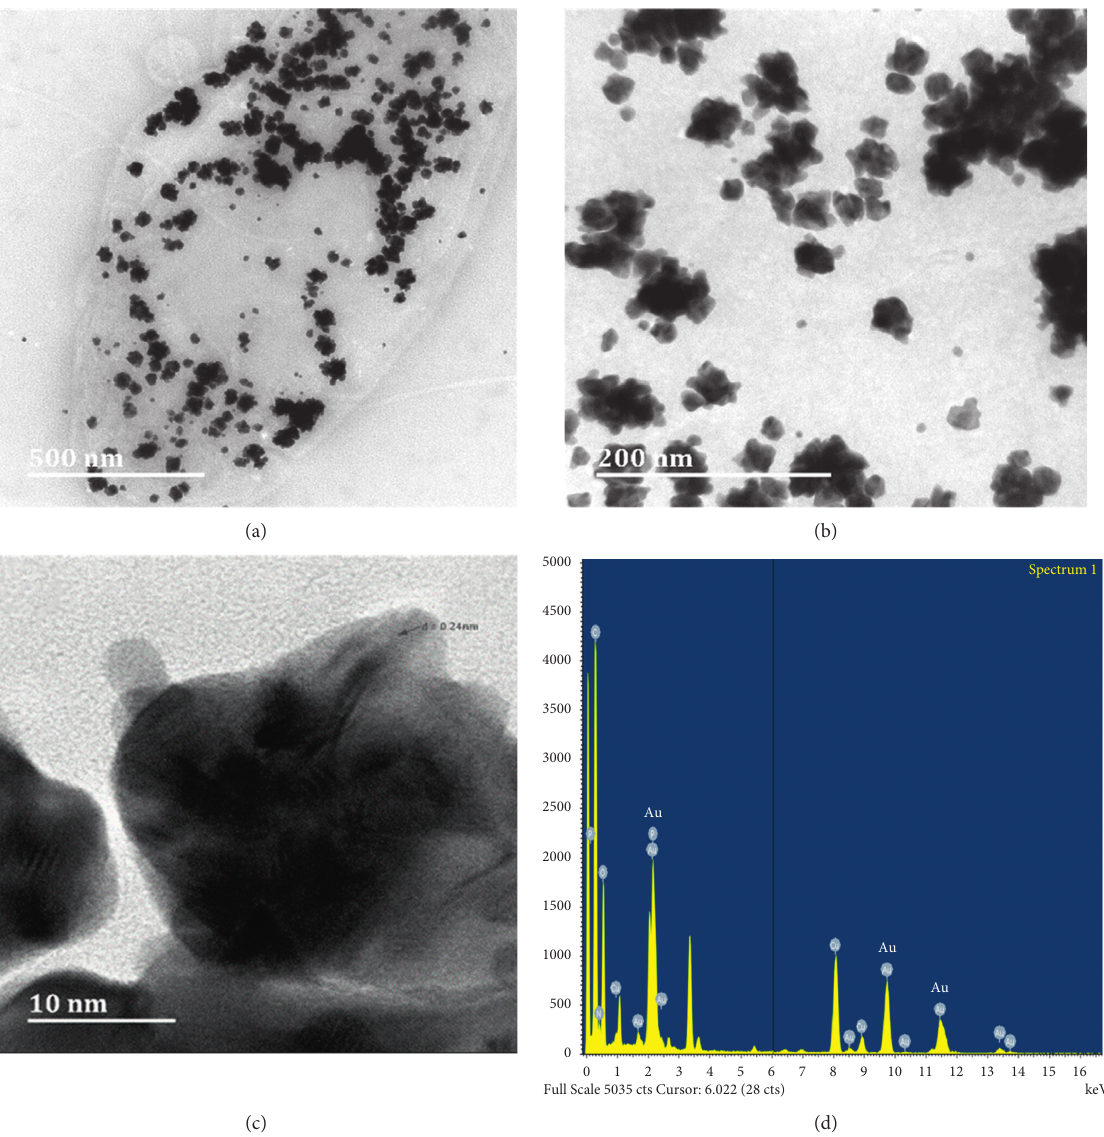
Figure 1: (a) TEM images of Magnetospirillum magnetotacticum with gold nanoparticles, (b) isolated gold nanoparticles, (c) lattice fringes, and (d) EDX